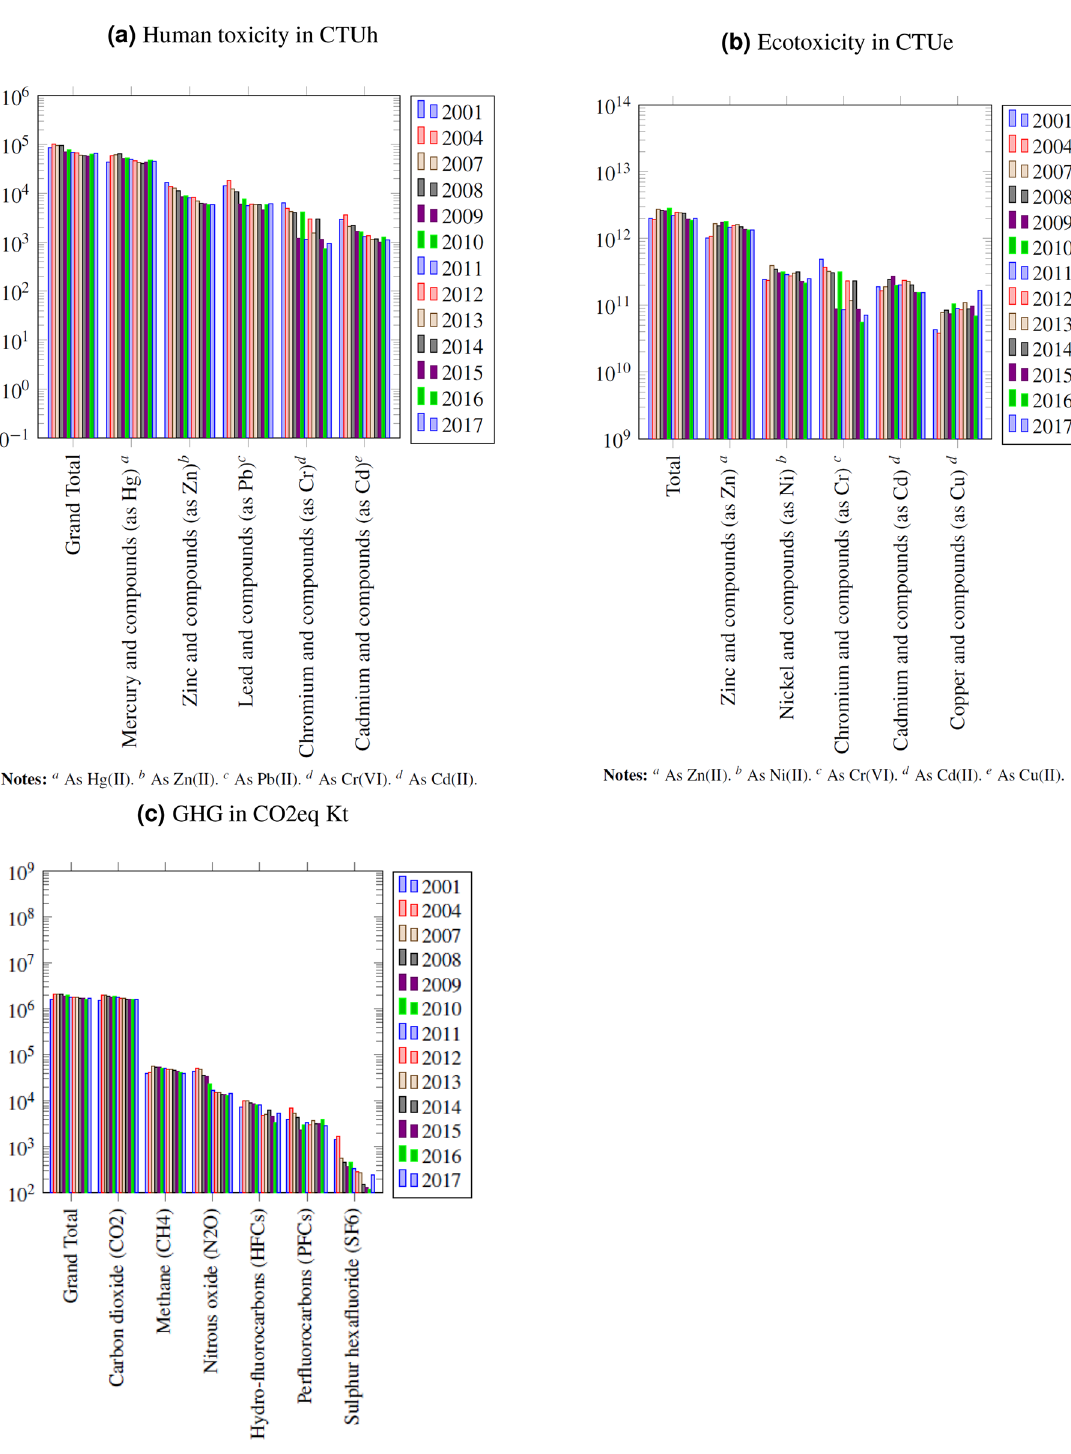
Figure 3. Trend of contribution of substances to human toxicity (CTUh), ecotoxicity (CTUe) and global warming (CO2) impact potentials emitted from European point sources to air and water (2001–2017), characterized with USEtox 2.12. Only the total contribution and the five substances with largest contributions are shown. Assumptions made in characterization are given in the table footnotes. Under the European Pollutant Emission Register (EPER), data was reported every three year, first in 2001 and later in 2004. After 2007 data has been reported every